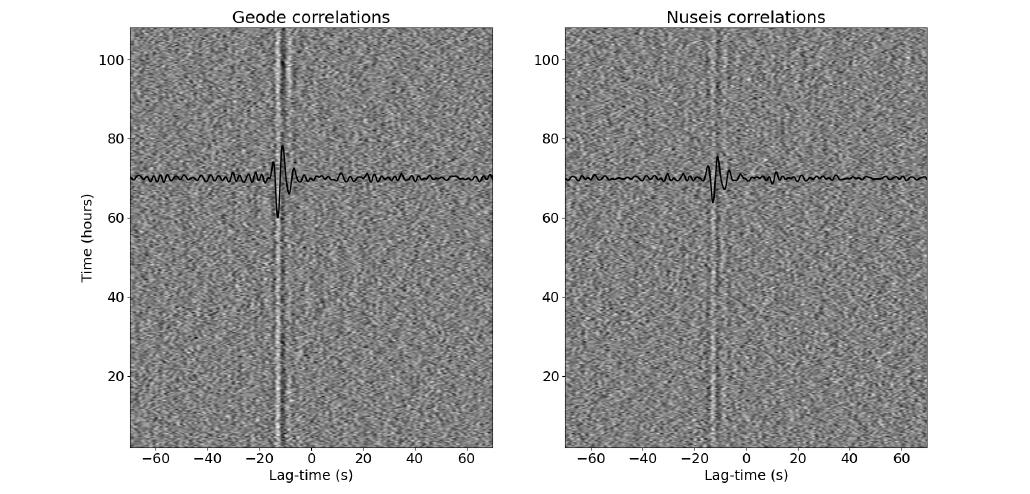
Figure 5. Comparison of the correlation functions for the Geodes compared to the Nuseis nodes. The waterfall plot shows the correlation function for each 20 min segment, while the black line shows the stacked correlation